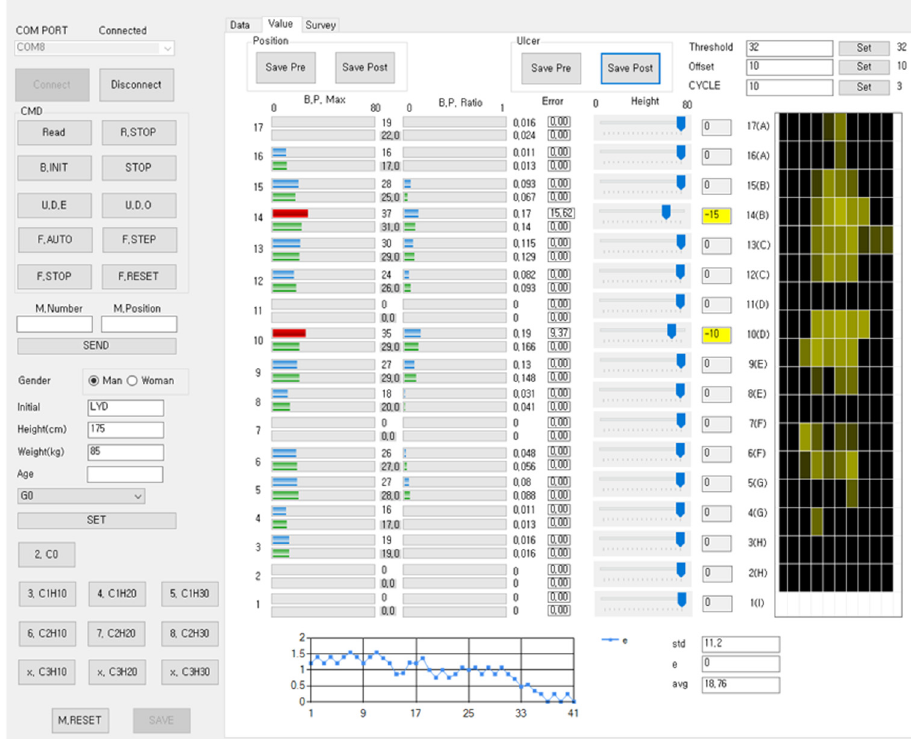
Figure 11. GUI screen.